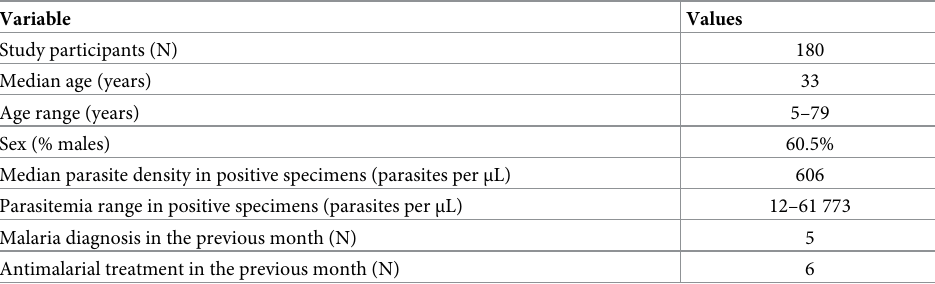
Table 1. Characteristics of participants enrolled in the